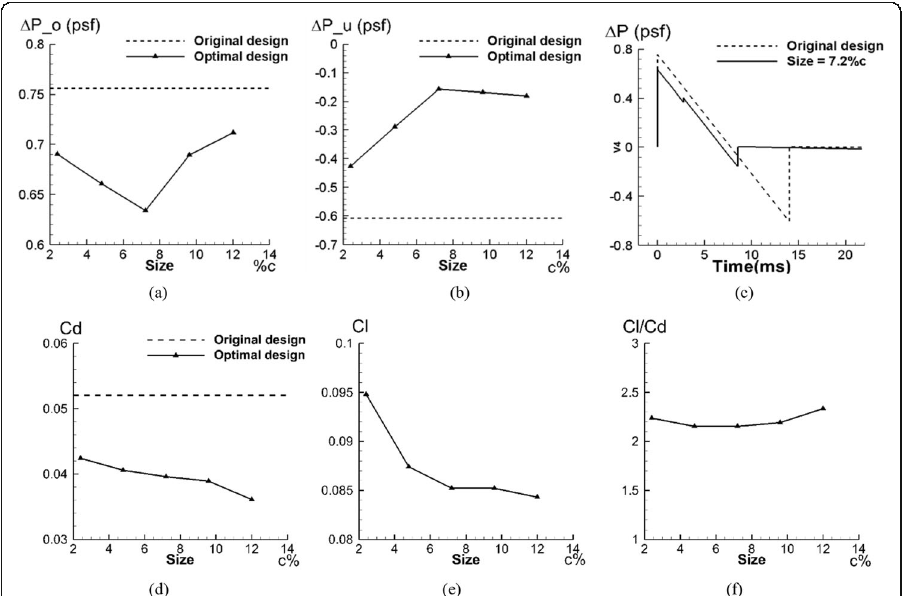
Fig. 17 The ground boom signatures and drag coefficients for the baseline and optimized NACA0008 airfoil with different suction and injection slot sizes. a the maximum overpressure vs the slot size; b the maximum underpressure vs the slot size; c comparison of the ground boom signature at the suction slot size = 7.2%c; d the drag coefficient vs the slot size; e the lift coefficient vs the slot size; f the lift-drag ratio vs the slot